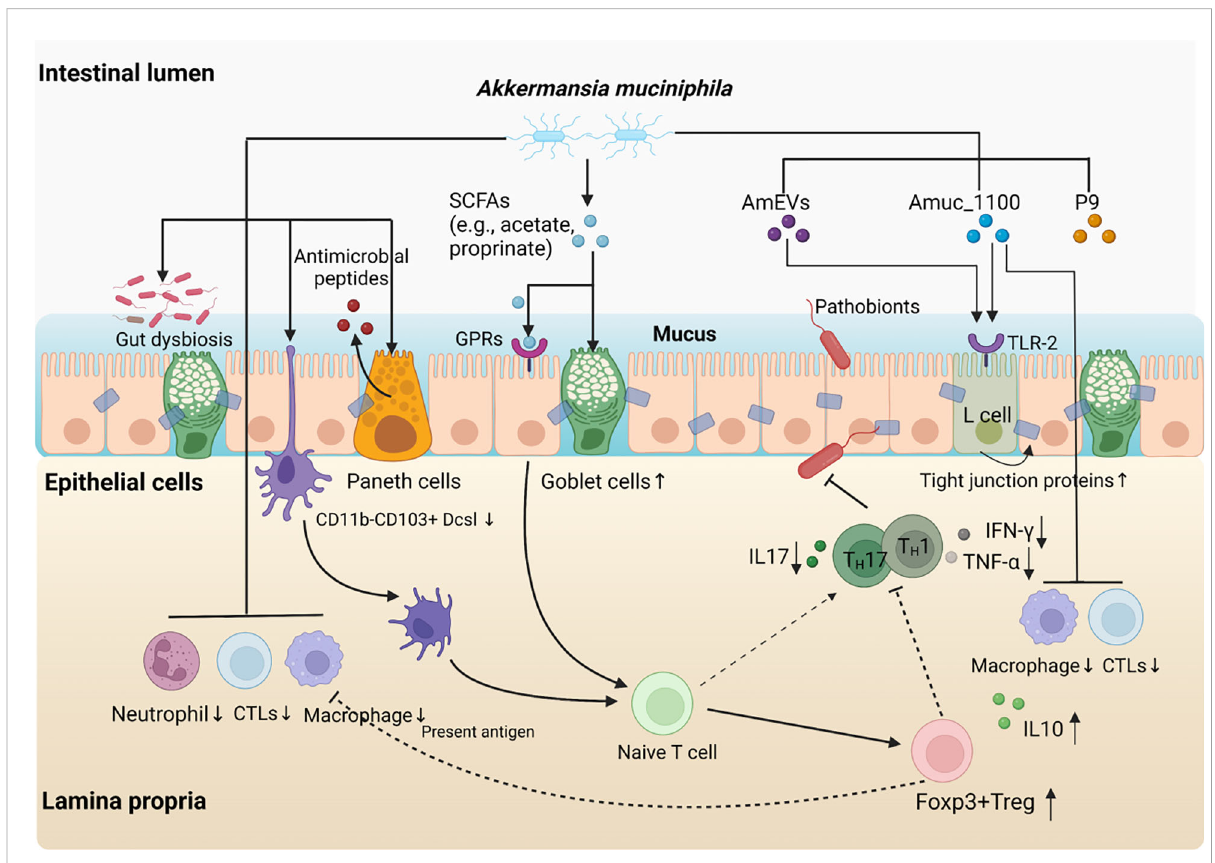
FIGURE 1 The role of A. muciniphila in in fl ammatory bowel disease. Supplement with A. muciniphila reduces the levels of colonic in fi ltrating macrophages and cytotoxic T lymphocytes (CTLs) and relieves intestinal in fl ammation. The protective effects of A. muciniphila on intestinal homeostasis are associated with increased numbers of goblet cells, enhanced mucus barrier and anti-microbial responses. A. muciniphila supplement partially attenuates gut dysbiosis and resist the colonisation against other pathogens. Moreover, A. muciniphila derived SCFAs promoted the conversion from Naïve T cells to Foxp3+Treg cells through GPRs signal pathway, which may be accompanied by reduced Th1/17